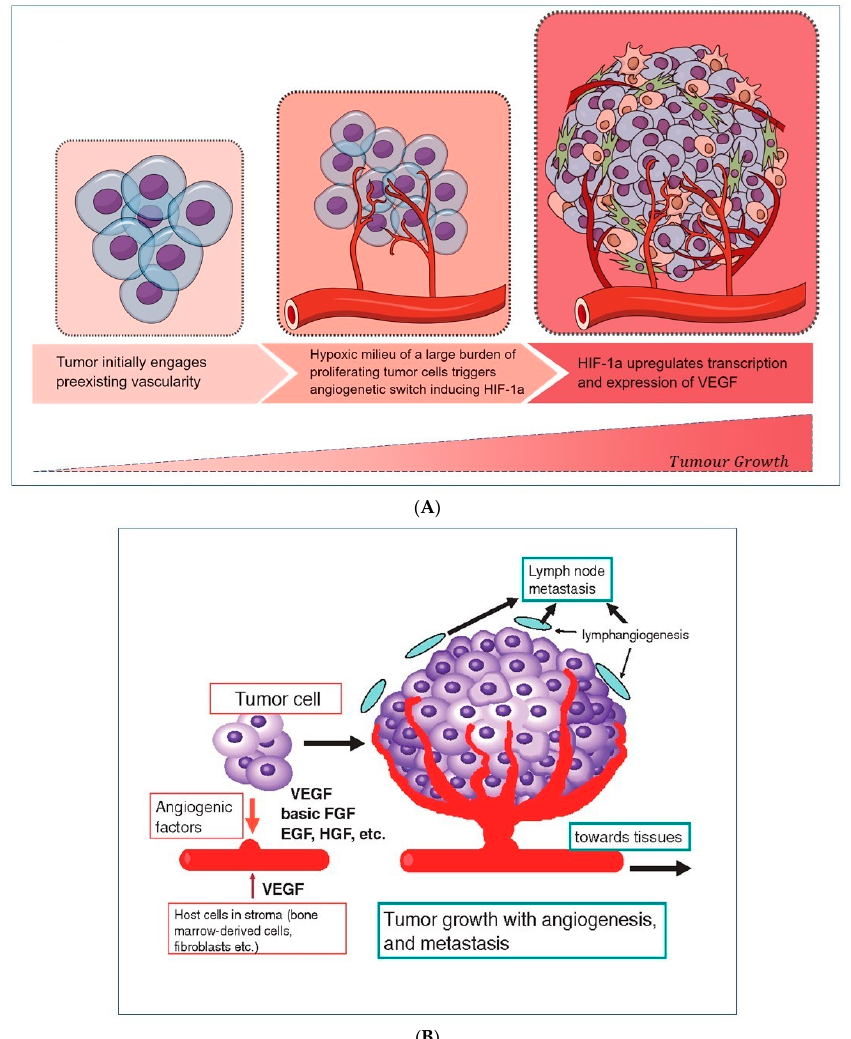
Figure 2. ( A ) Hypoxic environment stimulates neoangiogenesis, thanks to a circuit involving HIF-1 α -induced VEGF release by tumor cells. ( B ) A wide range of cellular released growth factors, derived from a tumor, stroma, and leukocytes, ensures the formation of new vascularity and the sustainment of cell growth, allowing the worsening progression of the initial tumor burden. The Tyrosine kinase proteins with Ig and EGF-homology domains 1 and 2 (Tie1 and Tie2) and their angiopoietin ligands 1–4 (Ang1, 2, 3, and 4) play a key role during the late phase of angiogenesis and are responsible for the maturation of newly established vascu- lar structures (Table 1). Ang1 and Ang2 have been deeply studied and characterized. The activity of the Angiopoietin/Tie system determines the stabilization of new vessels [25].